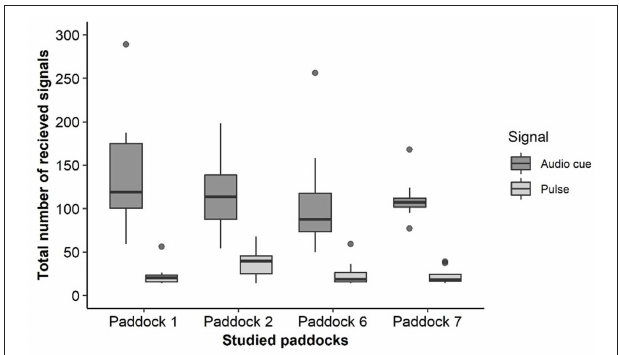
FIGURE 6 | Box plots of the total number of received audio and electrical pulse signals for the four test groups across the trial duration. Paddocks 1 and 7 were part of cohort 1, and paddocks 2 and 6 were part of cohort 2.